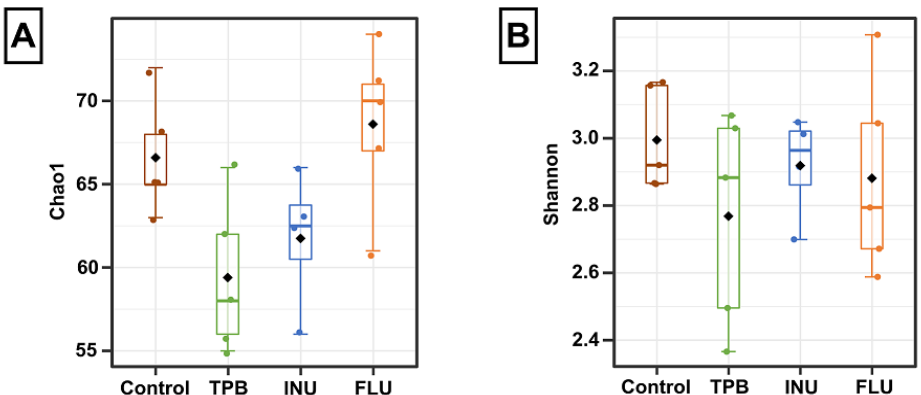
Figure 7. Alpha diversity indices calculated for different treatment groups. ( A )—Chao1 index; ( B )—Shannon index. The results were analyzed using the Kruskal–Wallis test. Data are presented as the mean ± SE.